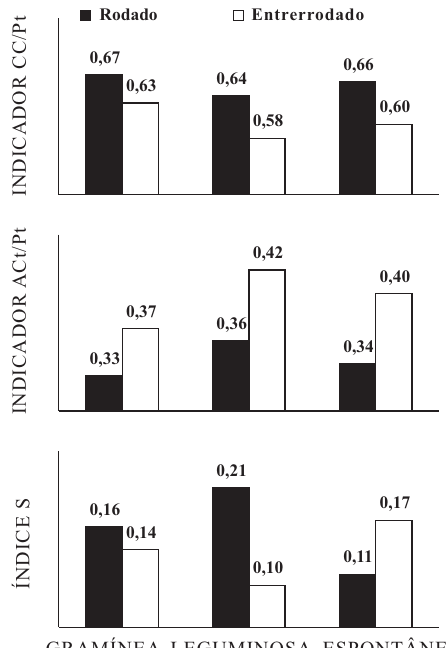
Figura 3. Indicador do armazenamento de água no solo (CC/Pt), indicador da capacidade de aeração do solo (ACt/Pt) e índice S para as posições de amostragem (rodado e entrerrodado) e vegeta- ções (gramínea, leguminosa e